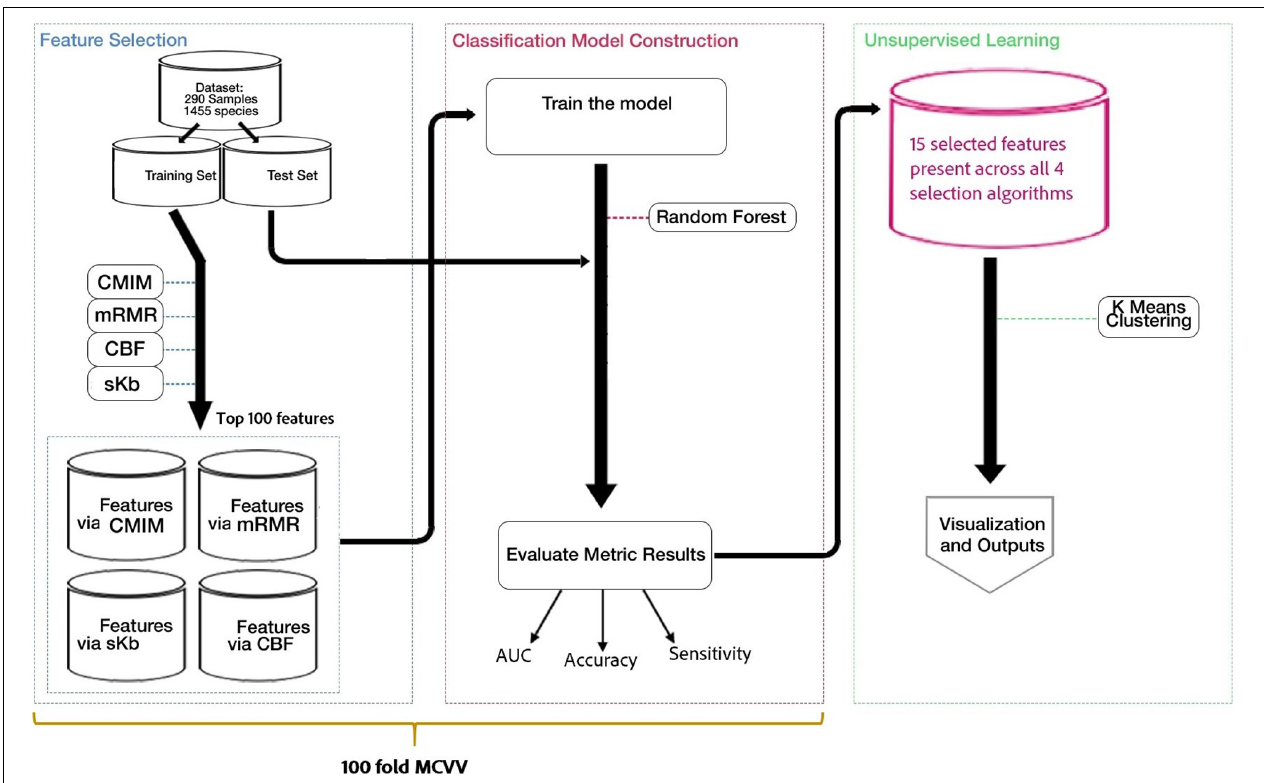
FIGURE 1 | Flowchart of our method, including three main parts. (i) Feature selection methods are applied to detect the most important species for the development of T2D (T2D-associated microorganisms). (ii) Using the selected features, models are constructed and used for classification. (iii) K -means clustering algorithm is applied on data to specify subgroups of patients and control samples.